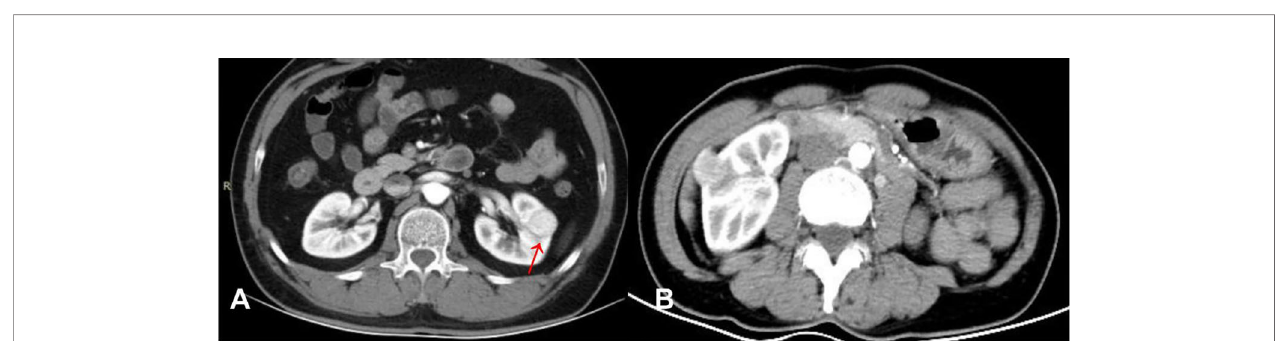
FIGURE 2 | (A) ccRCC in a 46-year-old male, post-contrast image depicted an unenhanced arc area between the lesion and renal parenchyma (arrow). (B) RAML-wvf in a 55-year-old male, there is no pseudocapsule sign that could be